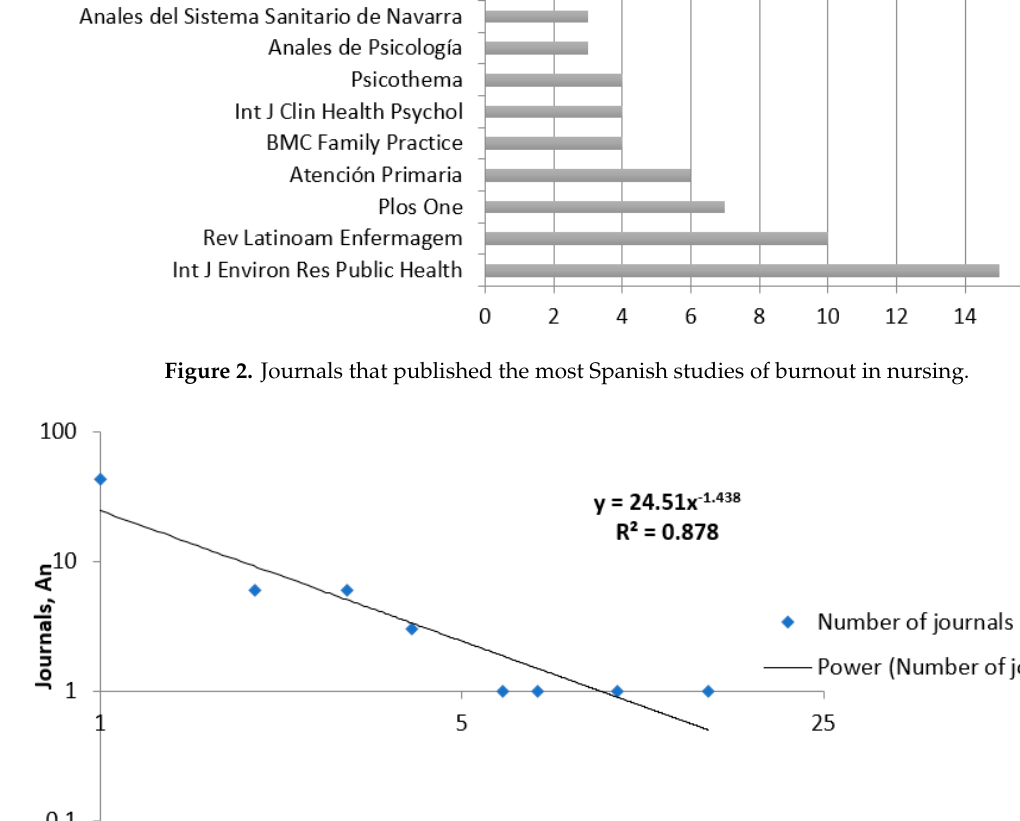
Figure 2. Journals that published the most Spanish studies of burnout in nursing.